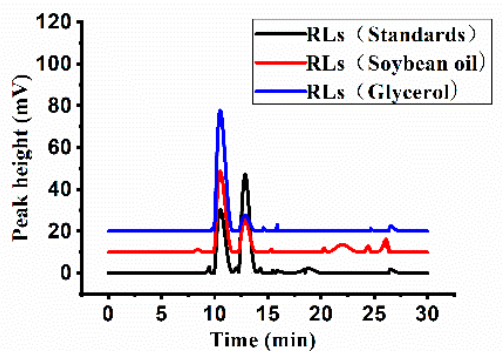
Figure 1. High performance liquid chromatography-evaporative light scattering detector (HPLC-ELSD) profile of rhamnolipids produced by P. aeruginosa YM4. The black line represents the rhamnolipid standard and the red and blue lines represent the rhamnolipids products from soybean oil and glycerol, respectively.